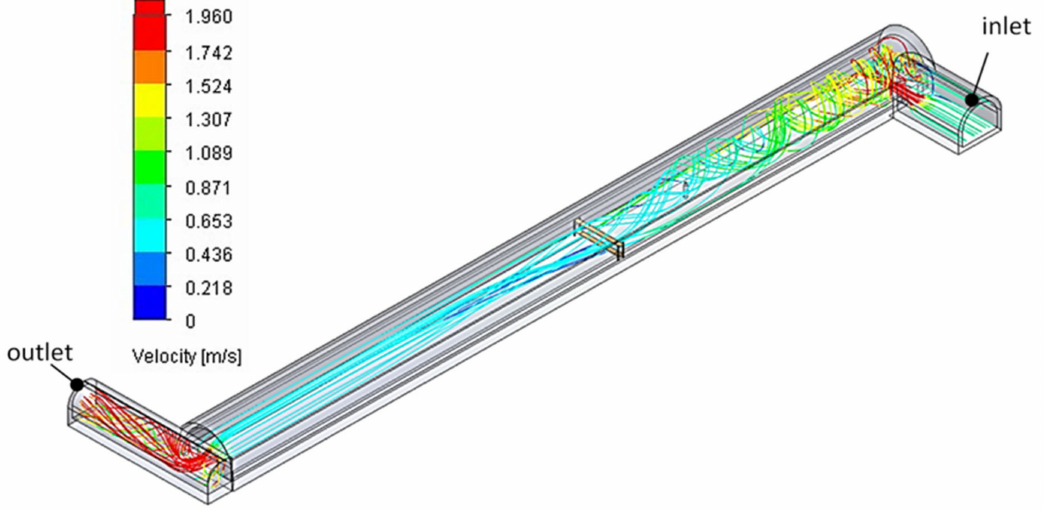
Figure 11. The trajectory of air flowing through the analyzed